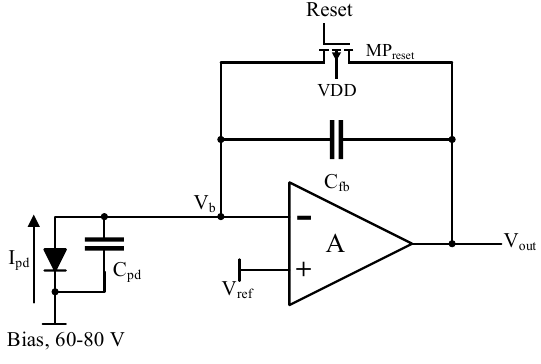
Figure 3. CTIA block